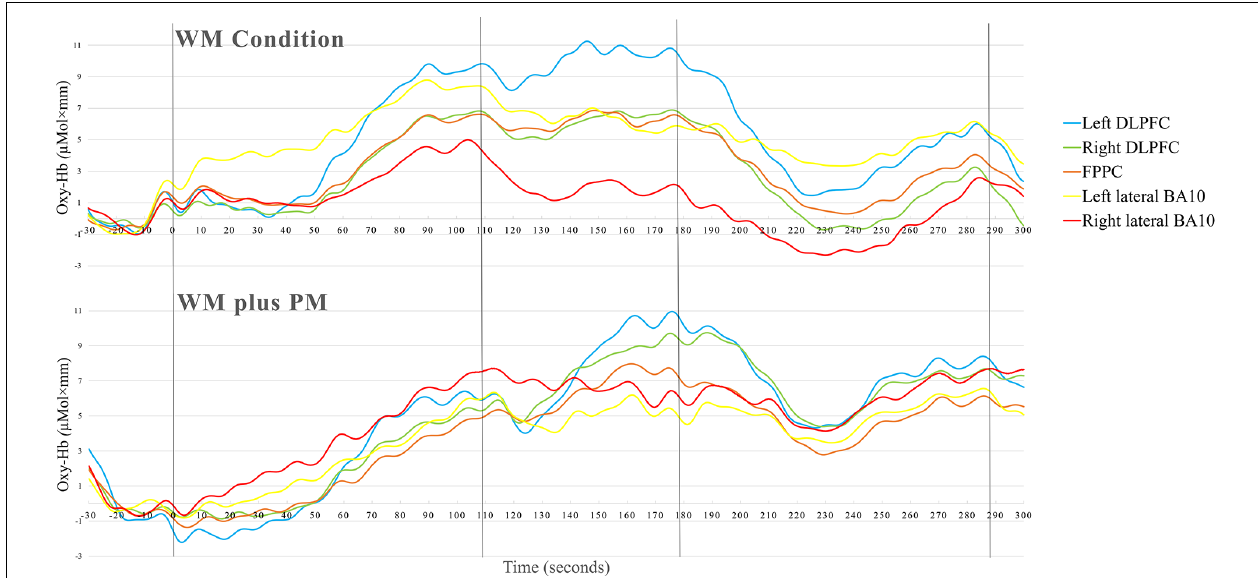
FIGURE 4 | Time course of the grand averaged (oxy-Hb) changes in WM condition and WM plus PM task.